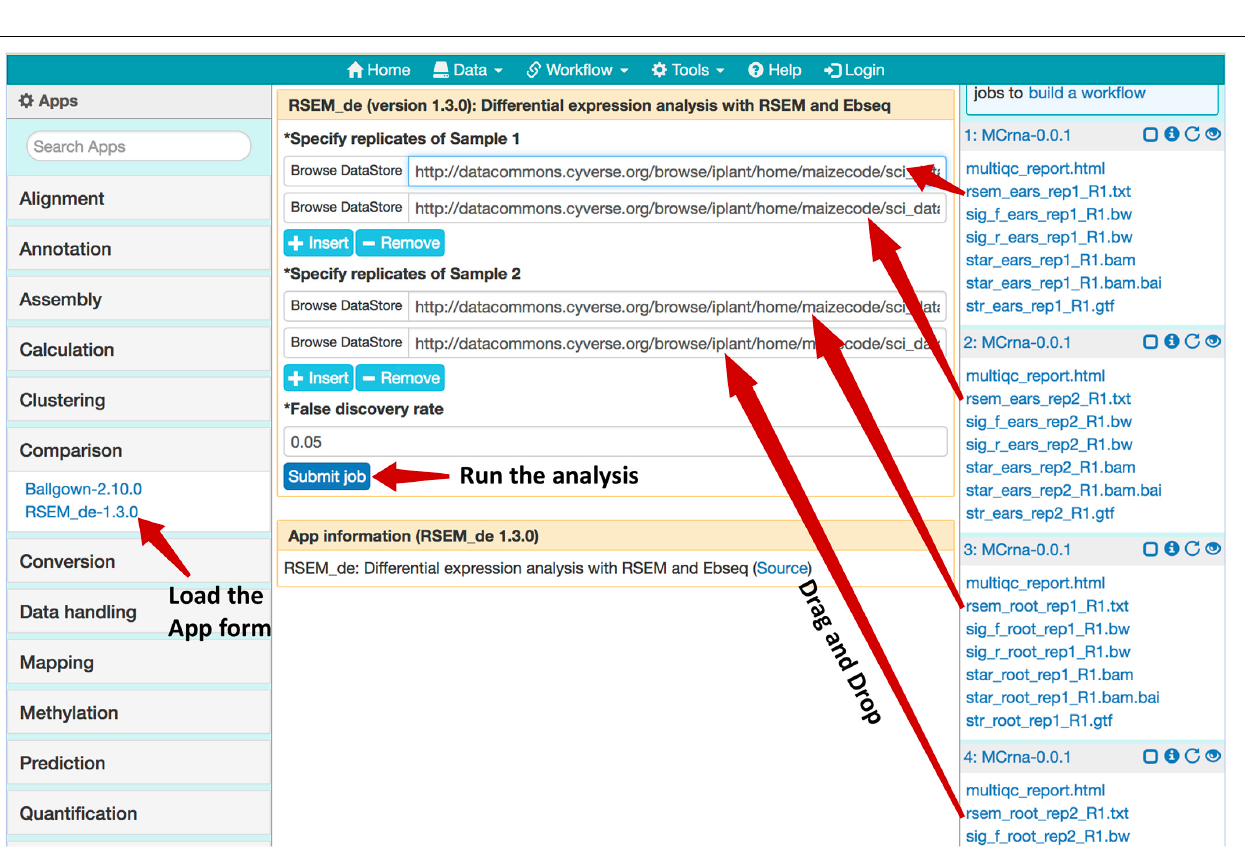
FIGURE 5 | Using the RSEM_de app for gene-level differential expression analysis. Job histories are “Loaded” from the MaizeCODE data page (https://www.sciapps.org/data/MaizeCODE); Clicking the RSEM_de-1.3.0 from the left App panel brings up the app form in the main panel; Dragging and dropping the gene quantification result files starting with “rsem_” into the input field, then clicking the “Submit job” button to run the differential expression